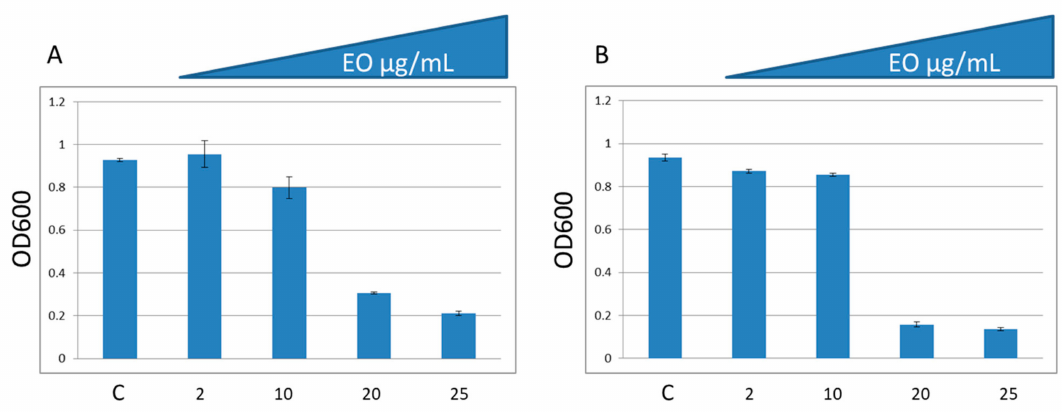
Figure 6. E ff ect of EO on growth of two MDR S. aureus isolates ( A — S. aureus strain 11; B — S. aureus strain 5). Data are average from triplicate experiments. Bars represent standard deviations of triplicate